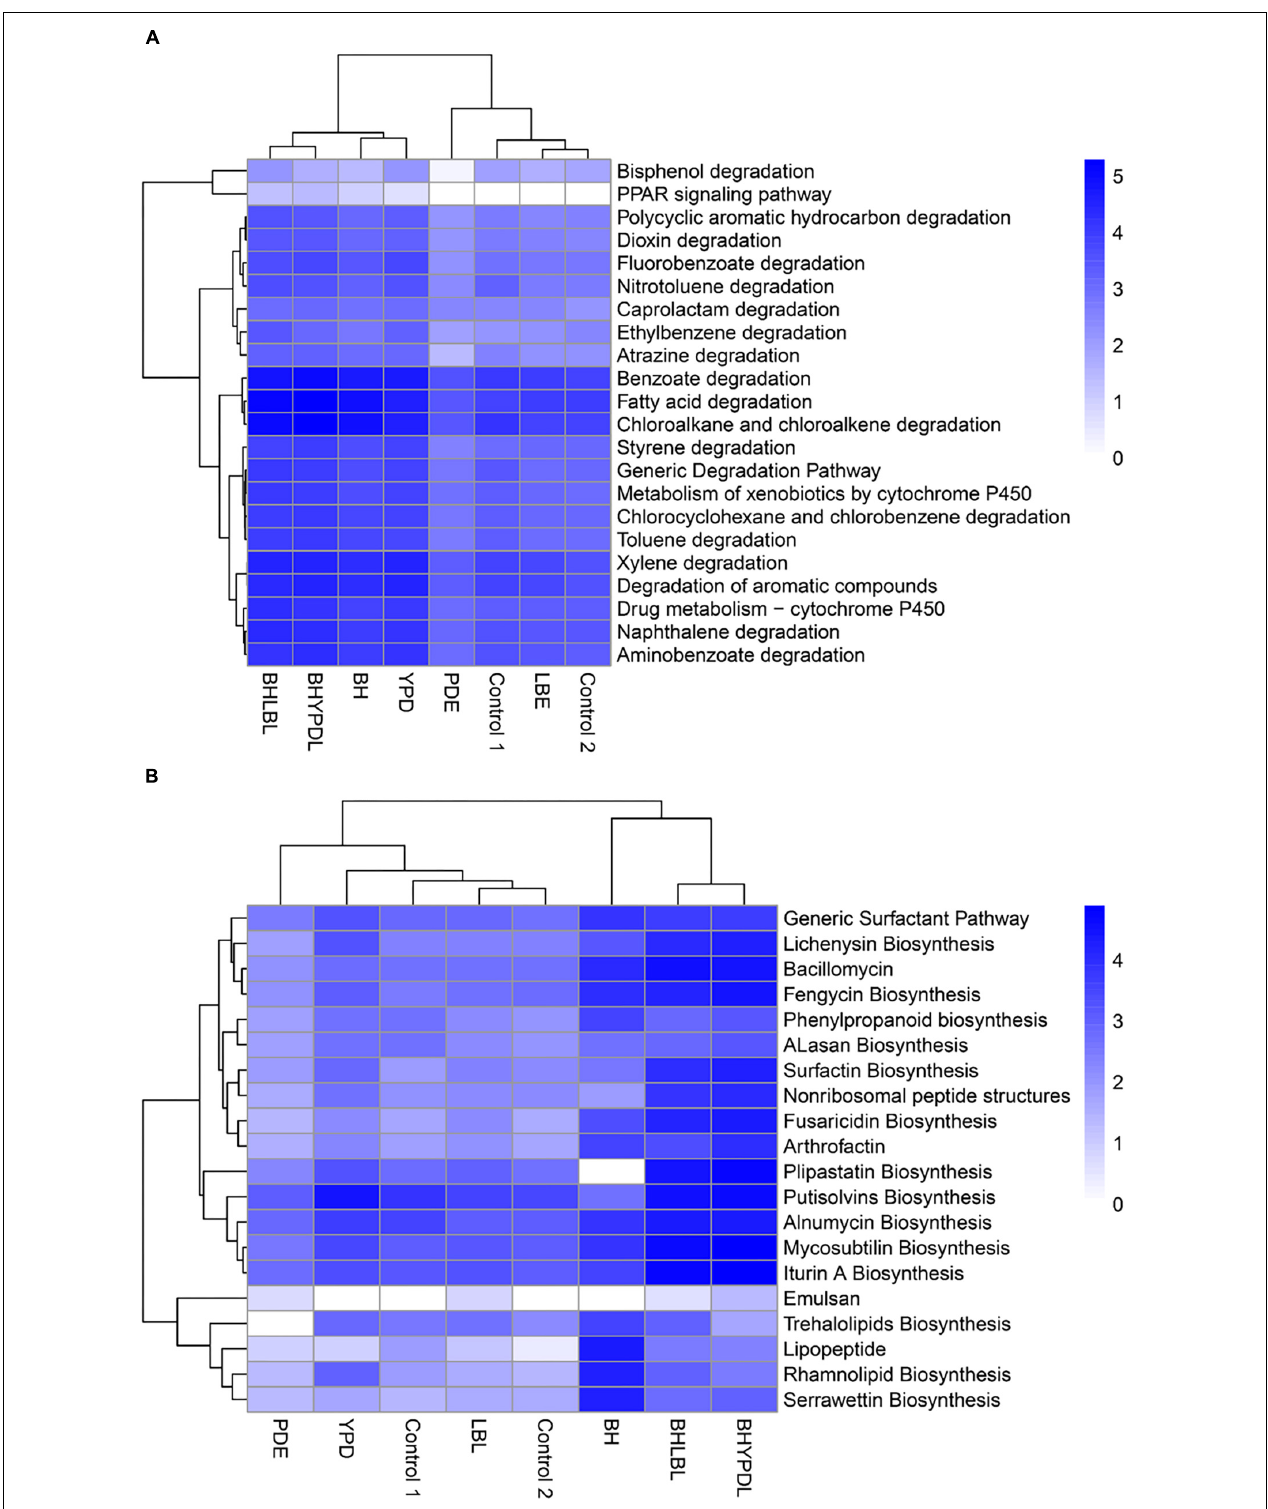
FIGURE 5 | Cluster analysis of biodegradation and biosurfactant biosynthesis pathways in the consortia. The influence of the consortia obtainment medium on the abundance of biodegradation and biosurfactant genes was analyzed. (A) Clustering of genes involved in hydrocarbon biodegradation pathways. (B) Clustering of genes involved in biosurfactant biosynthesis pathways. The clustering was based on the abundance of reads annotated in each pathway. Heatmap colors are generated with log 10 among the individual samples. A heatmap was generated using the heatmap package in the statistical program R.